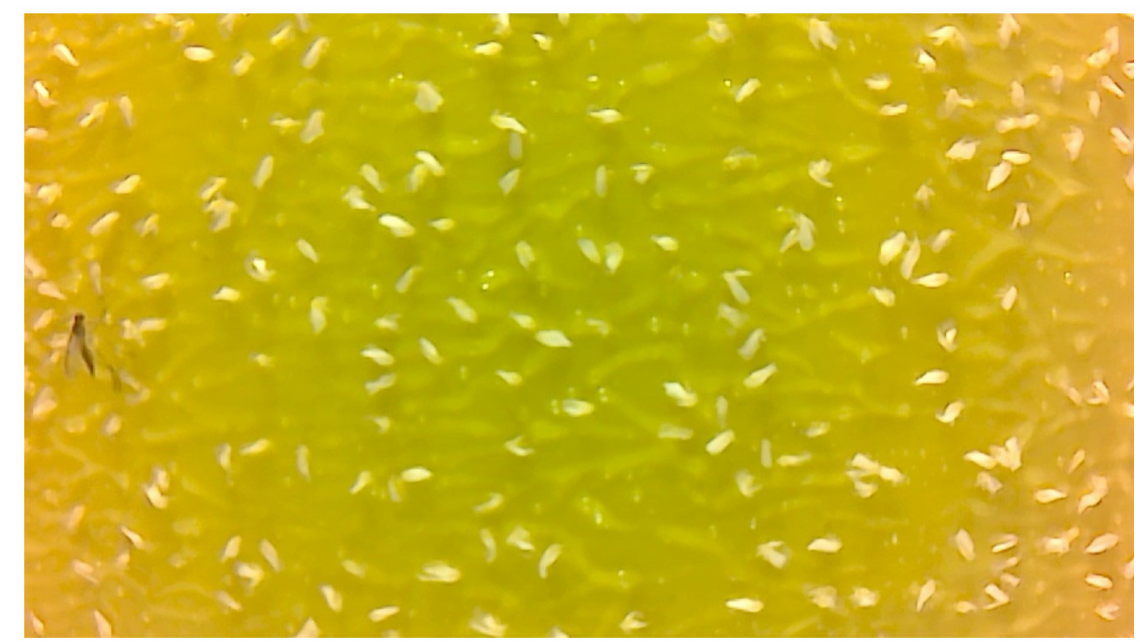
Figure 3. Whiteflies trapped on YST (yellow sticky tape).